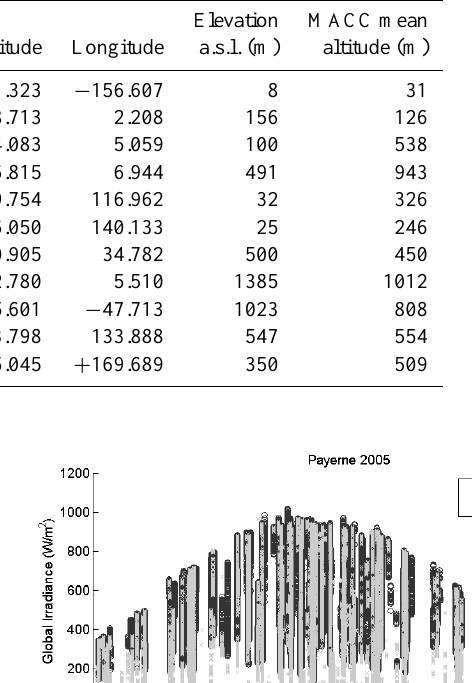
Table 1. List of BSRN stations used for validation.